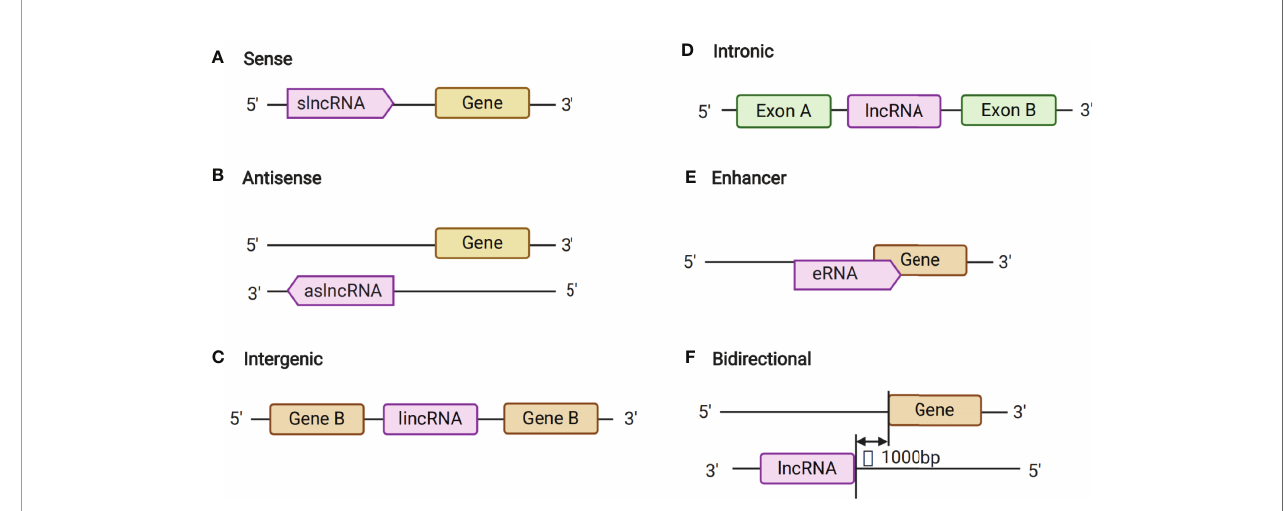
FIGURE 1 | Long Non-coding RNA (lncRNAs) Biogenesis. (A – F) The different kinds of biogenesis of